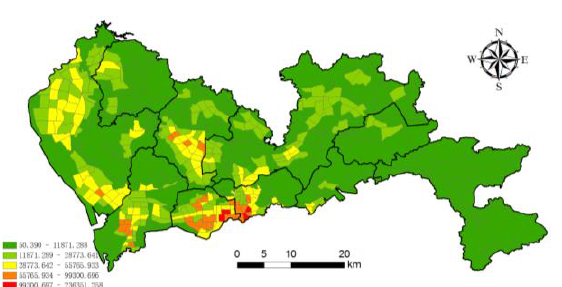
Figure 7. Spatial distribution of travel spatial density inferred from mobile phone data